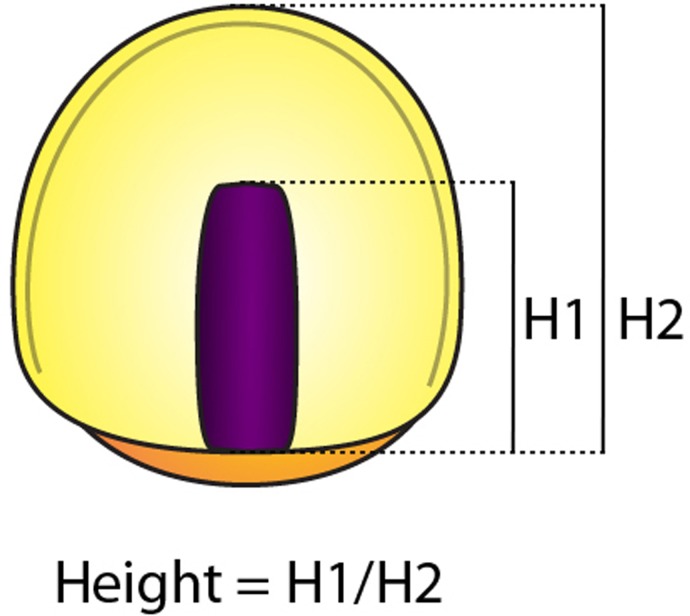
Measurement of the height,.The height was obtained from the ratio between H1 (distance from the margin to the leading cell) and H2 (distance from the margin to the animal pole).